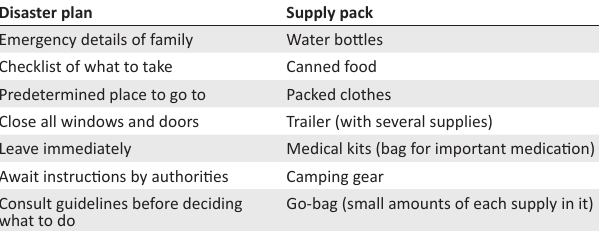
TABLE 3: List of respondents’ varied disaster plans and supply-pack